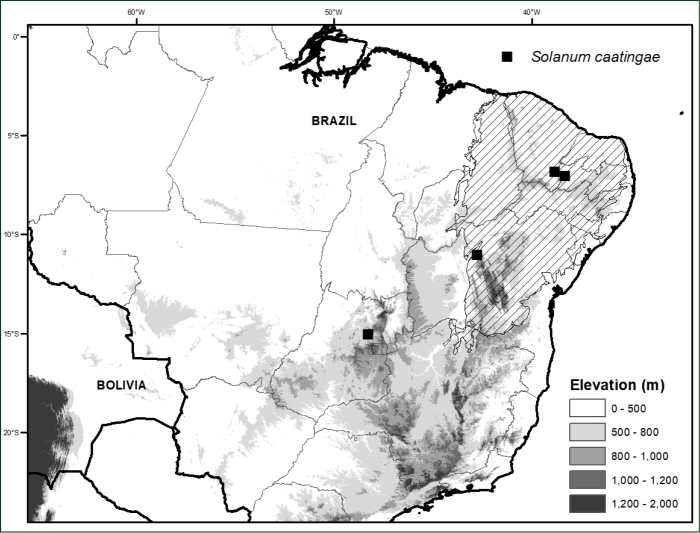
Distribution of Solanumcaatingae. Hatched area indicates the Caatinga Biogeographic Domain (sensu IBGE 2004).